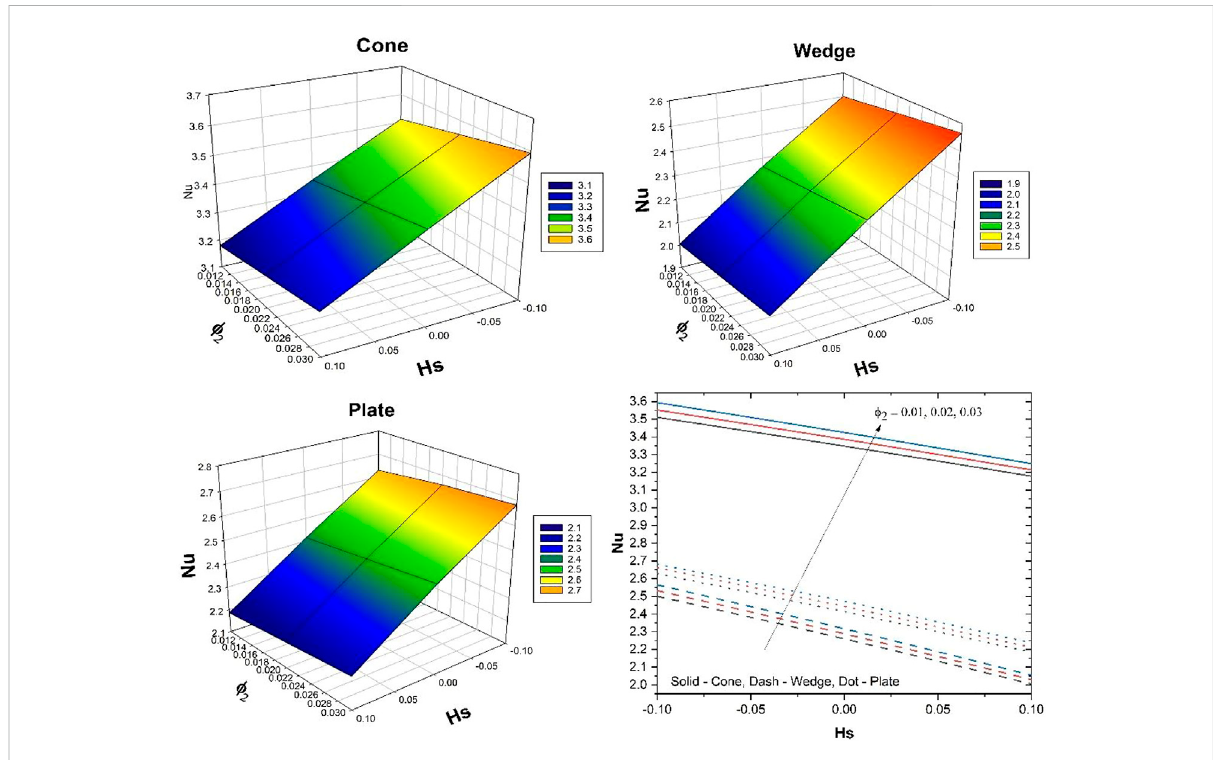
FIGURE 5 Behavior of Nu over Hs for various values of ϕ 2